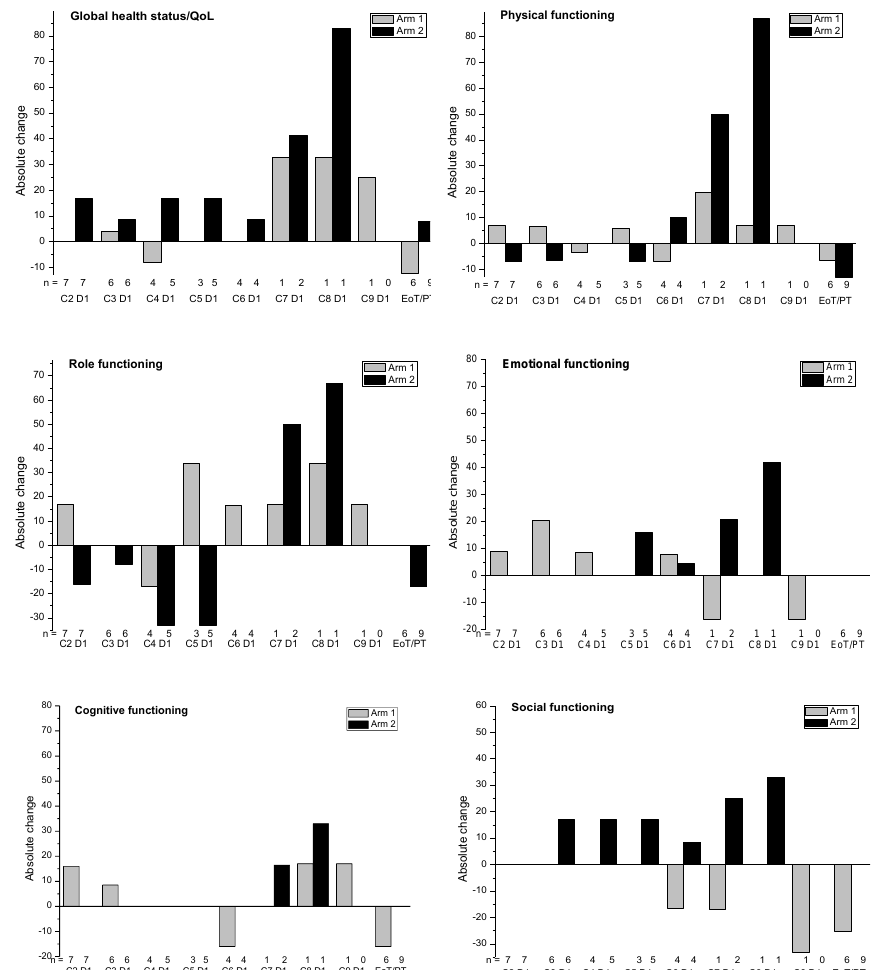
Figure 4. Absolute change from baseline in the global health status/quality of life and functional scales (EORTC) during the treatment period (Safety analysis set, N = 23). C = cycle; D = day; EoT = end of treatment; FU-1 = follow-up visit 1; PT = premature termination.